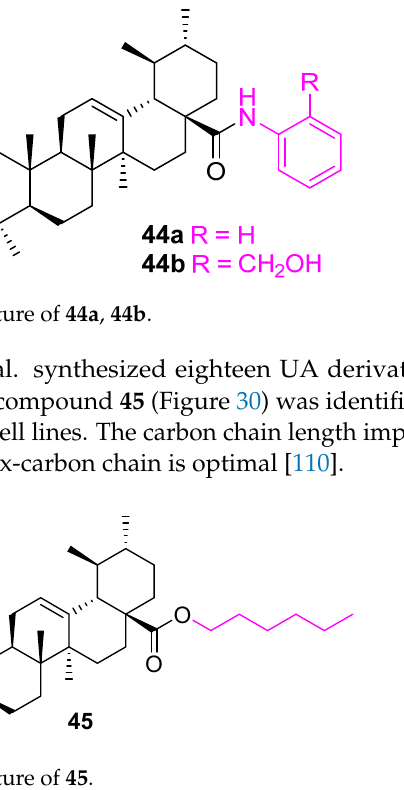
Zhao et al. synthesized UA analog ( 46 ) (Figure 31) by modifying at the C3 and C28 positions and incorporating an O-[4-(1-piperazinyl)-4-oxo-butyryl moiety. Compound 46 showed 8–10-fold enhanced anticancer properties (against MCF7, Hela, and A549 cell lines) in comparison to the parent UA [111].